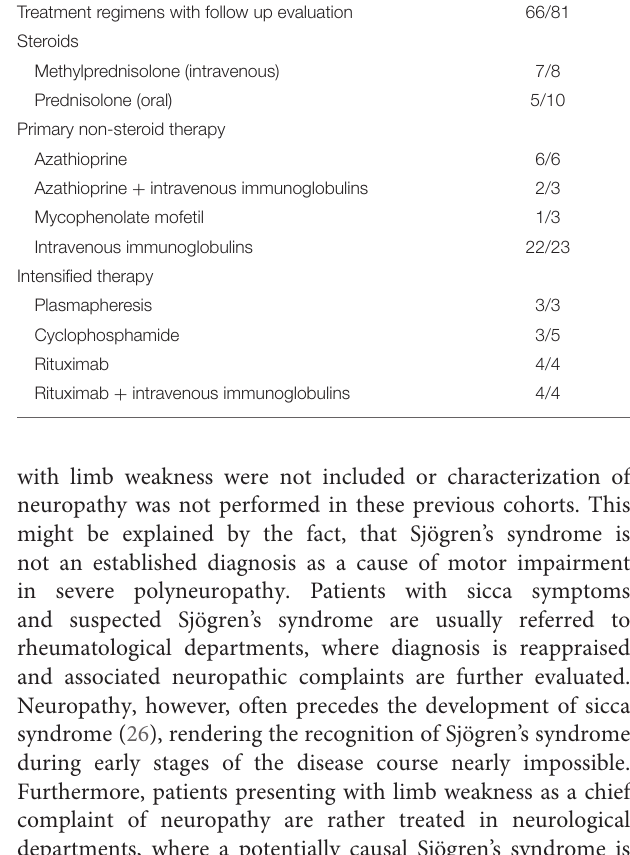
TABLE 5 | Therapeutic profiles administered in at least 3 patients. Treatments Favorable